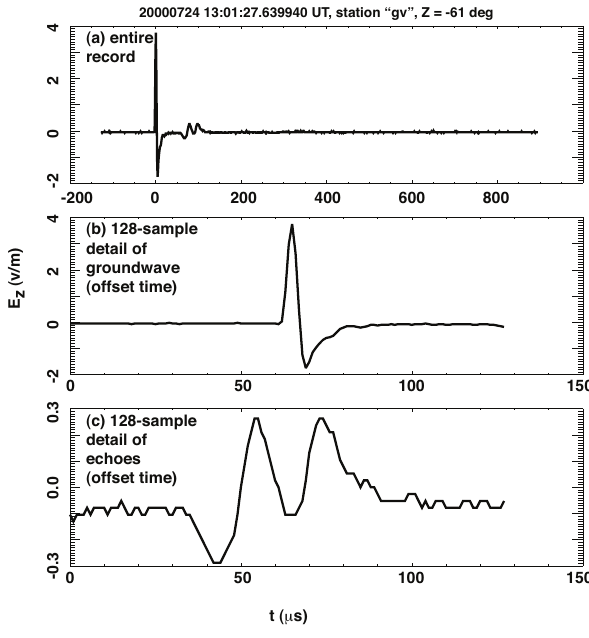
Fig. 3. Example of time-domain data from the Gainesville sta- tion, taken with solar zenith angle at ground Z = − 61 deg. (a) en- tire record (1000 samples at 1 sample per µ s), (b) 128-sample cen- tered on the ground wave, (c) 128 samples centered on the two iono- spheric